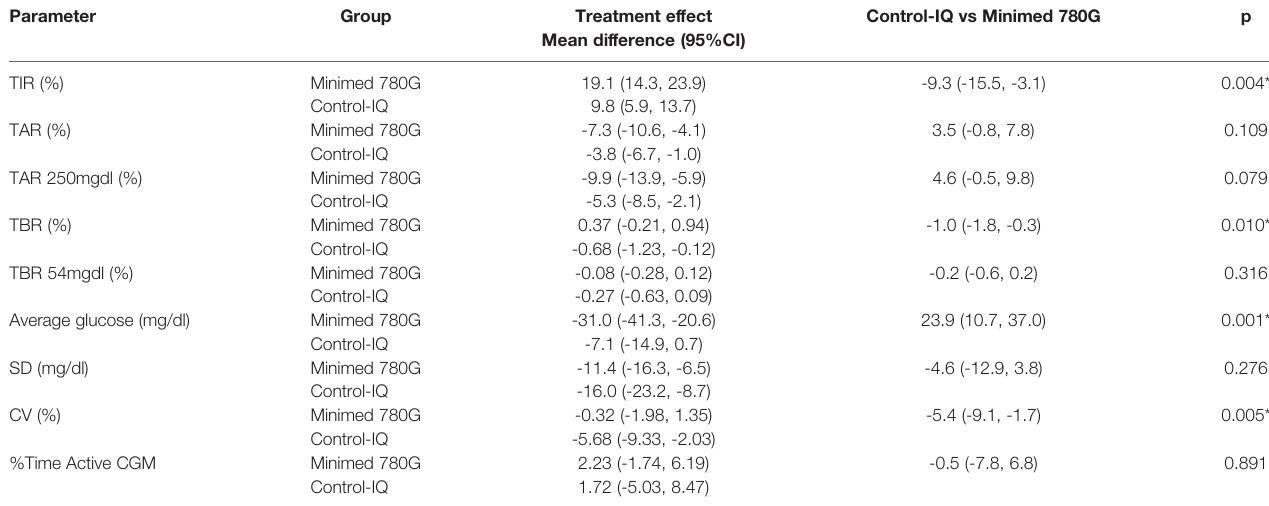
TABLE 3 | Treatment effects by